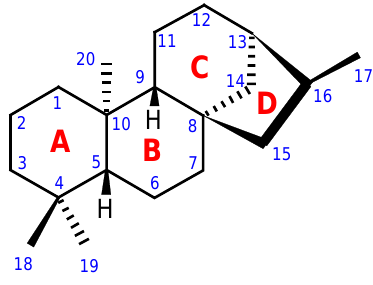
Figure 3. Carbon-skeleton of an ent -kaurane diterpene [7].